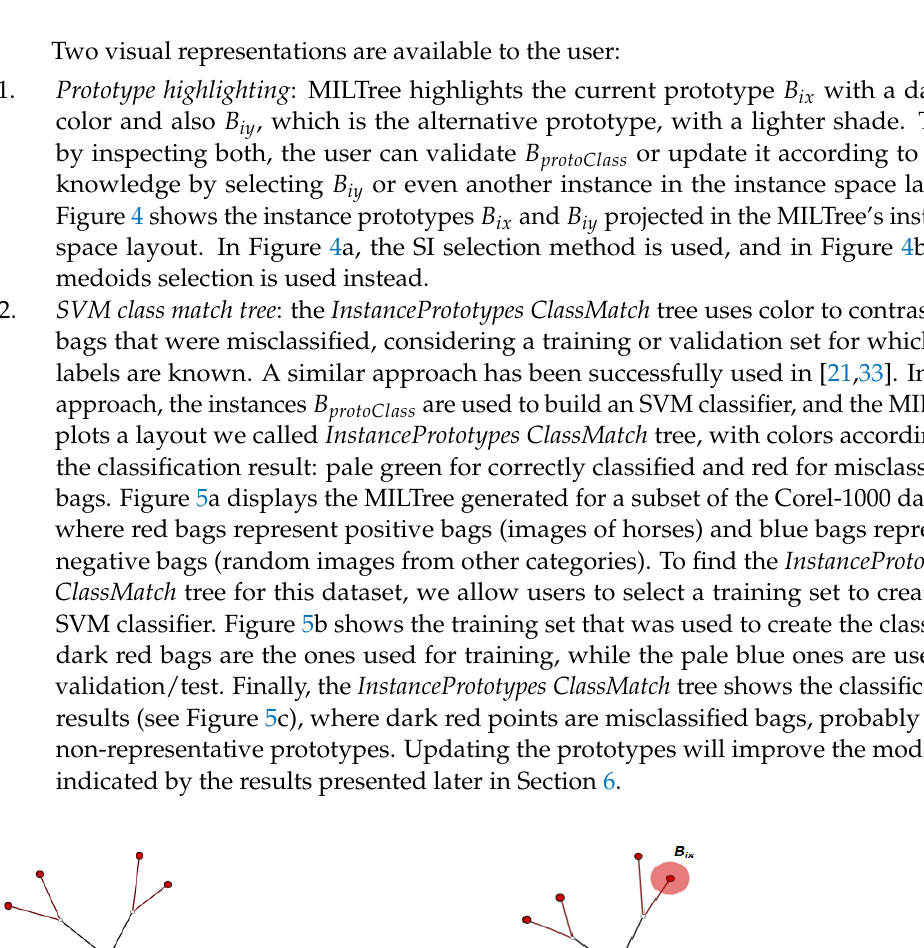
Figure 3. Selection of instance prototype using MILTree-Med.